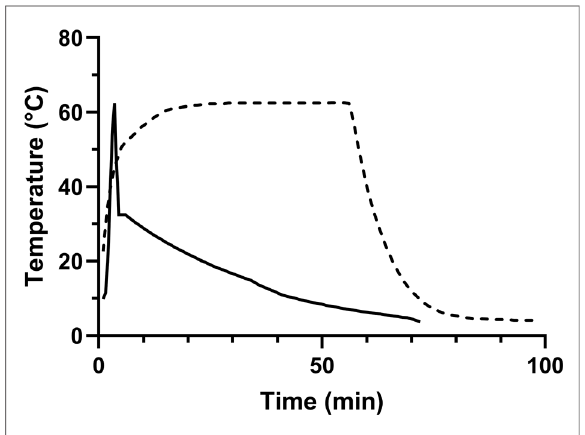
FIGURE 2 Exemplary time-temperature curve of the pasteurisation processes. Dashed line=Holder pasteurisation; Straight line=high temperature short time (HTST)